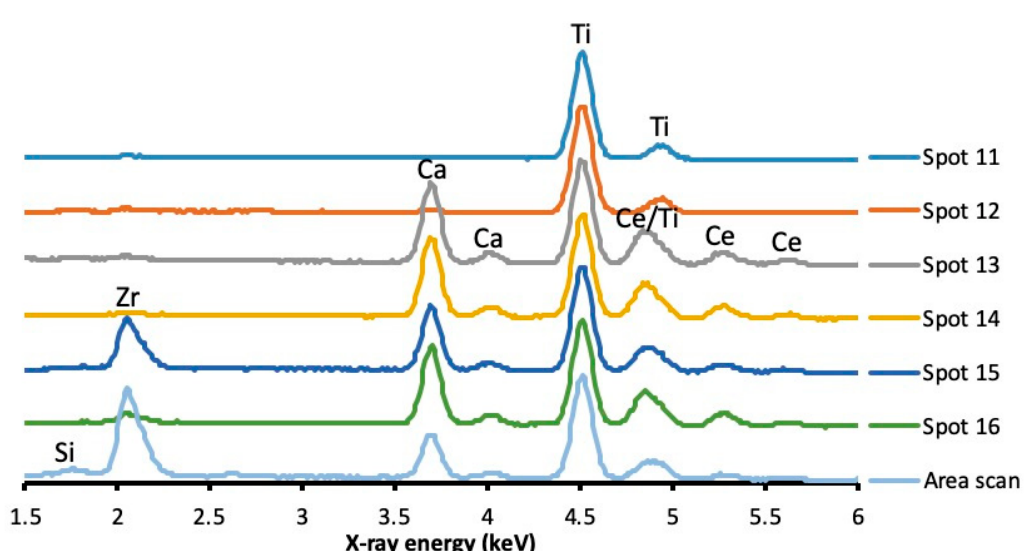
Figure 14. EDX spectra of rutile and perovskite inclusions in a zirconolite particle after leaching in sodium carbonate.